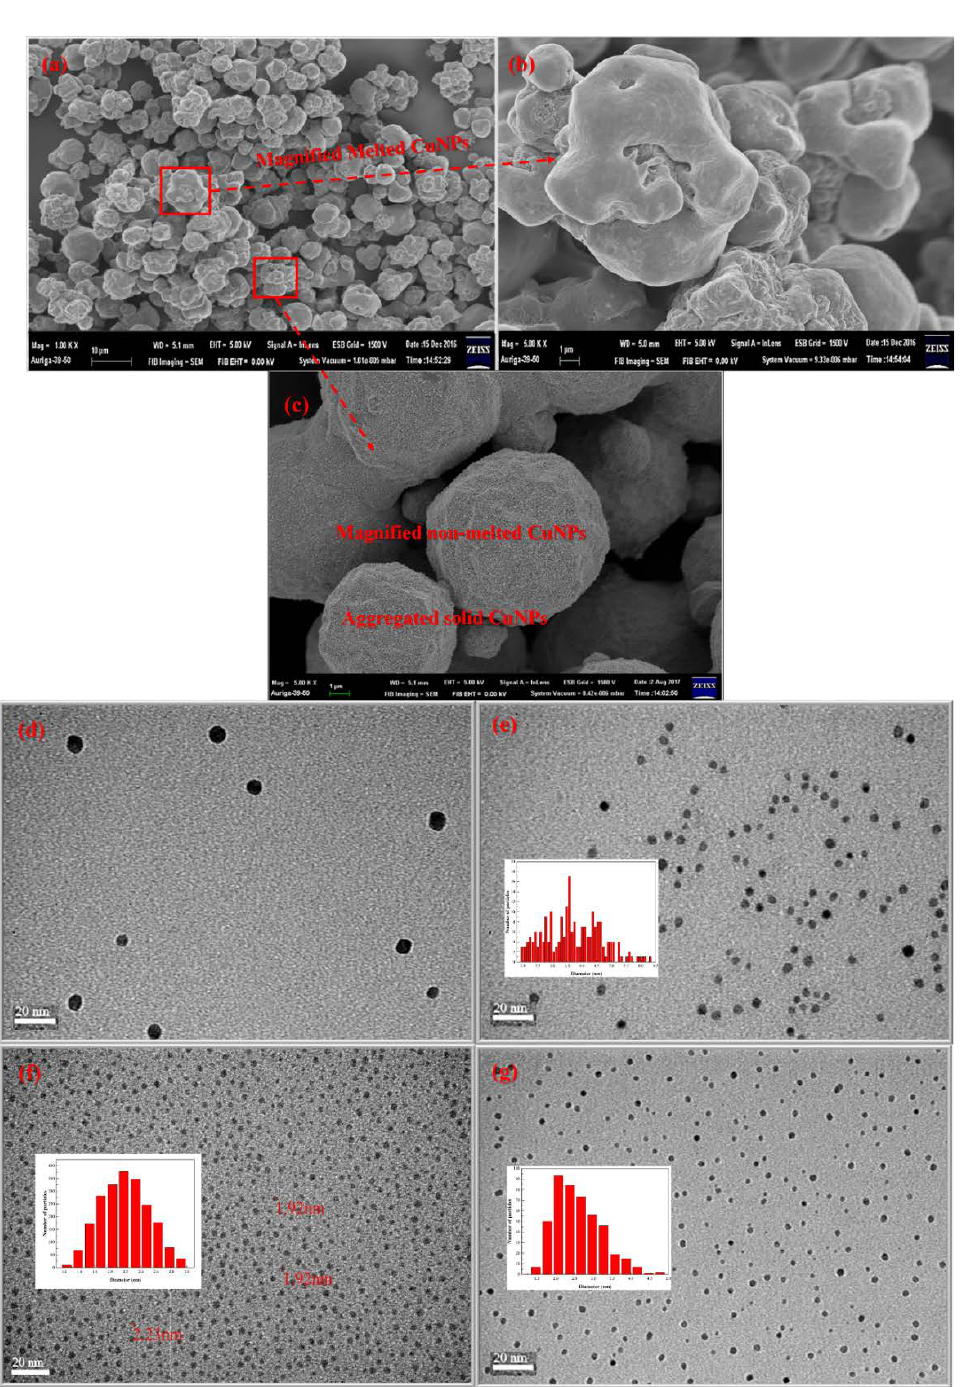
Figure 1. Different magnifications of SEM micrographs of Cu-NPs prepared from MW irradiation in the presence of TETA ( a – c ); TEM micrographs of TETA/Cu 2+ prepared with different ratios ( d ) 1.5/1 ( e ) 2.0/1 ( f ) 2.5/1 ( g ) 3.0/1.